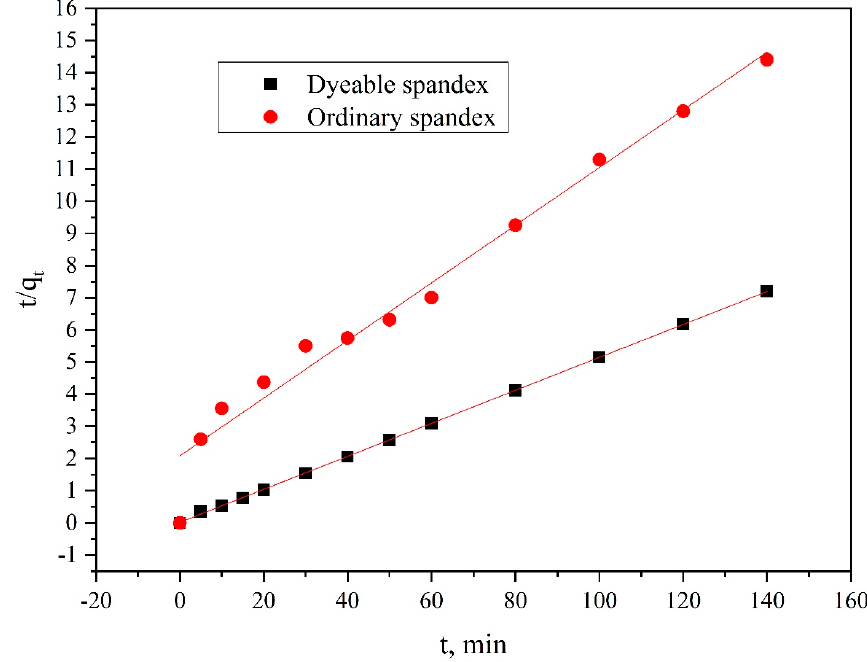
Figure 10. Pseudo–second-order kinetic model of neutral red G dyeing spandex.